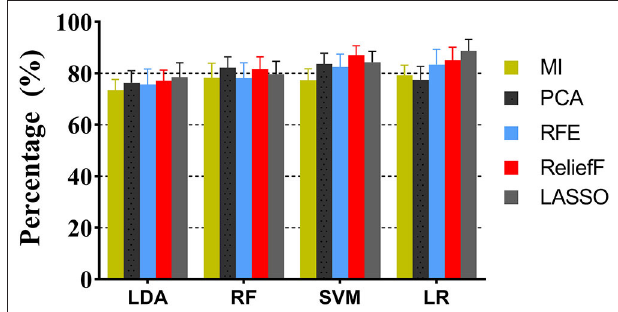
FIGURE 4 | The performance comparison of machine learning models with different feature selection methods.